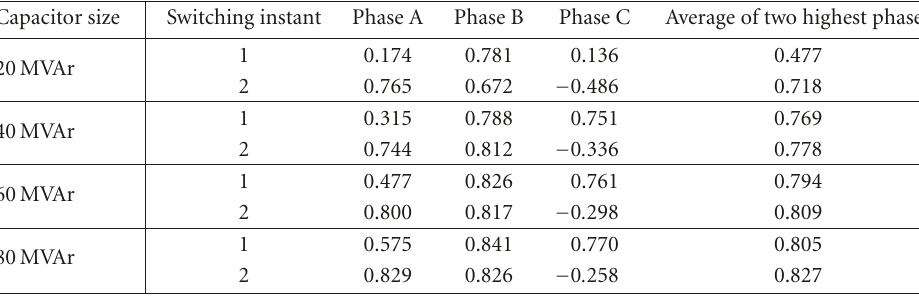
Table 3: Results of back-to-back capacitor switching with 80 MVAr connected.